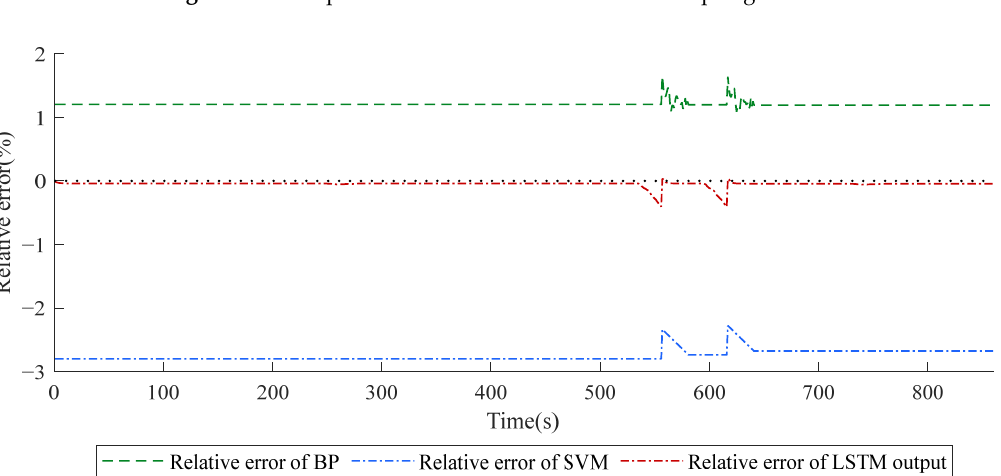
Appl. Sci. 2022 , 12 , x FOR PEER REVIEW Figure 7. A comparison of the forecast values for the spring data. Figure 7. A comparison of the forecast values for the spring data.